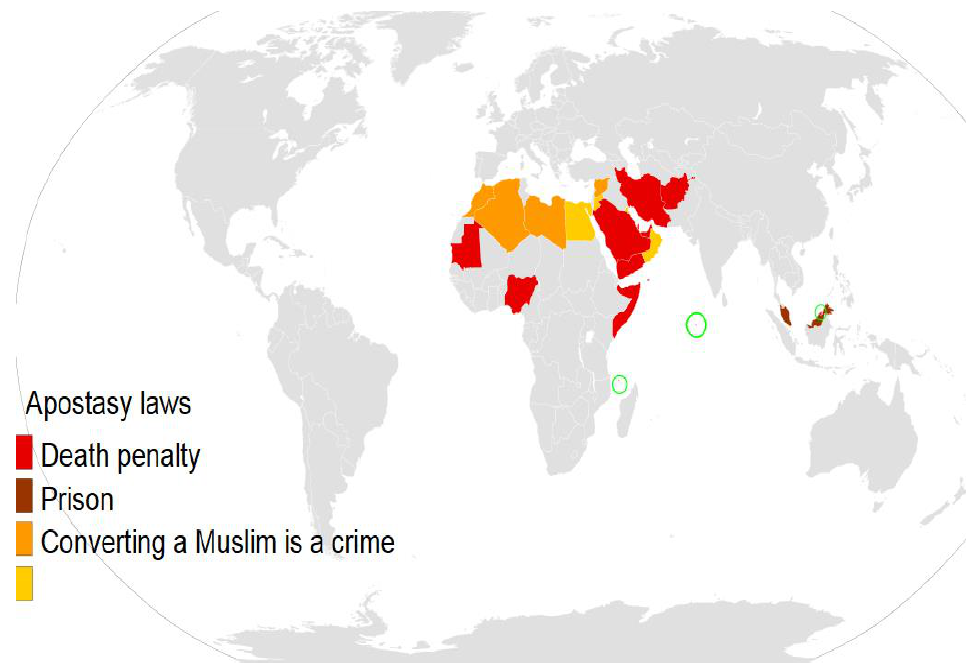
Religions 2021 , 12 , x FOR PEER REVIEW Figure A1. Laws criminalizing apostasy (Wayback Machine Library of Congress 2014). Figure A1. Laws criminalizing apostasy (Library of Congress 2014).